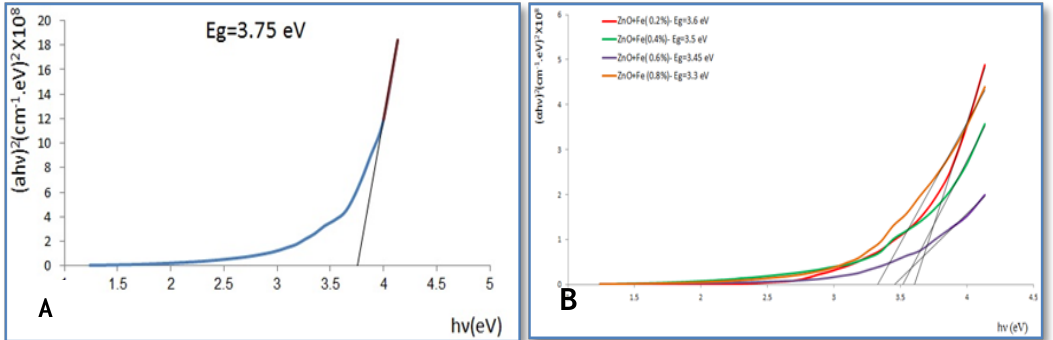
Fig.8: (αhν) 2 versus photon energy plot of (A) pure ZnO thin films (B) with different doping concentration of